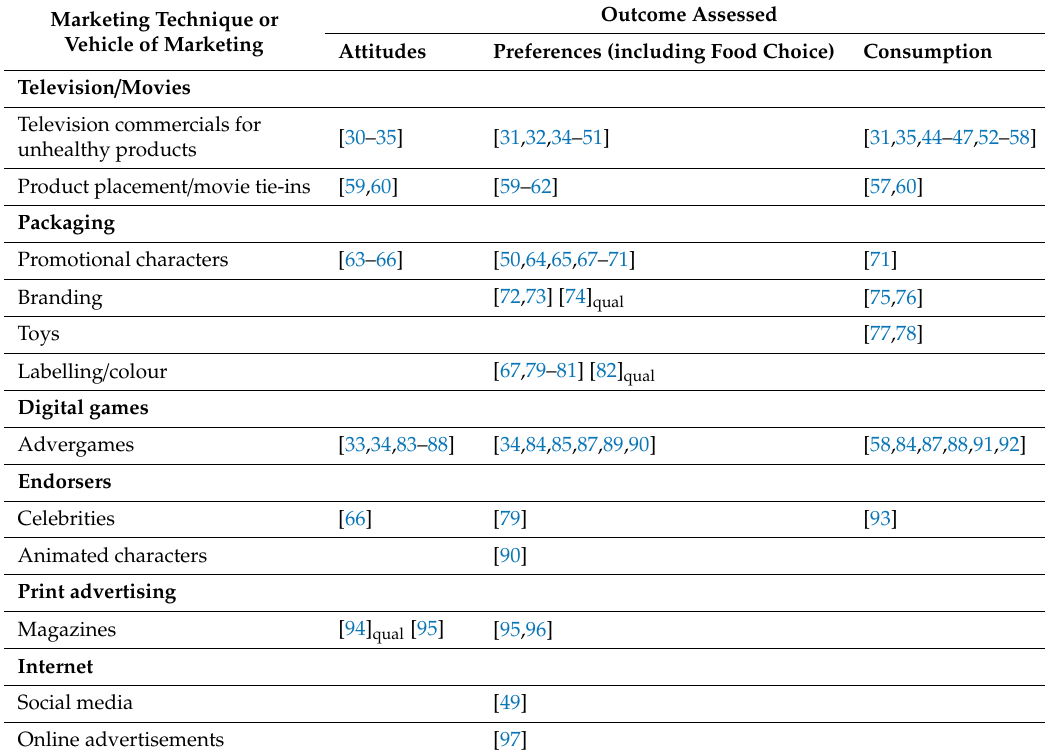
Table 1. Marketing technique or vehicle of marketing studied, outcome(s) assessed and the quality of the